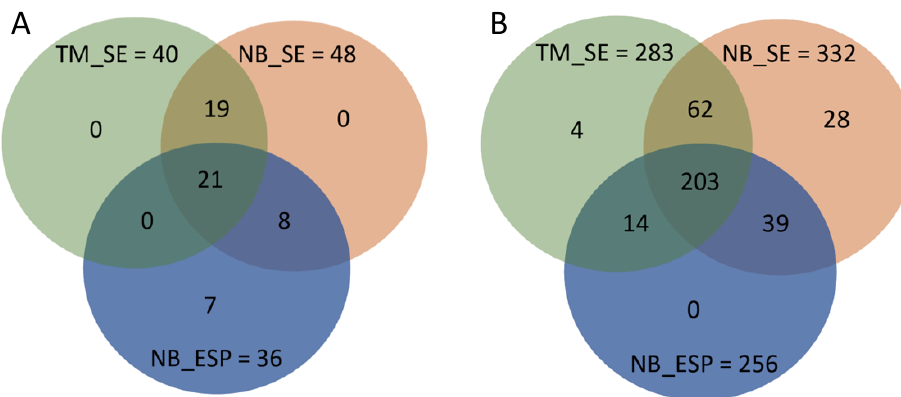
Figure 10. Distribution of common and unique metabolites among the three sample groups: the somatic extract of infective third-stage larvae (L3) of N. brasiliensis (NB_SE), the excretory/secretory products (ESP) of N. brasiliensis L3 (NB_ESP), and the somatic extract of T. muris embryonated eggs (TM_SE). ( A ) MSI-I identified polar metabolites; ( B ) MSI-II identified